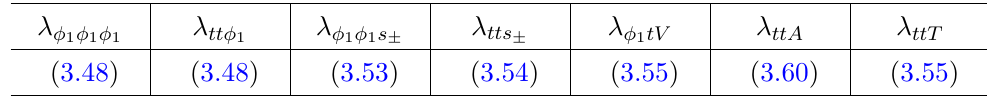
Table 1. Summary of the most important OPE coefficients computed in this section. Further coefficients appear in (3.50) or can be extracted from the four-point functions in section